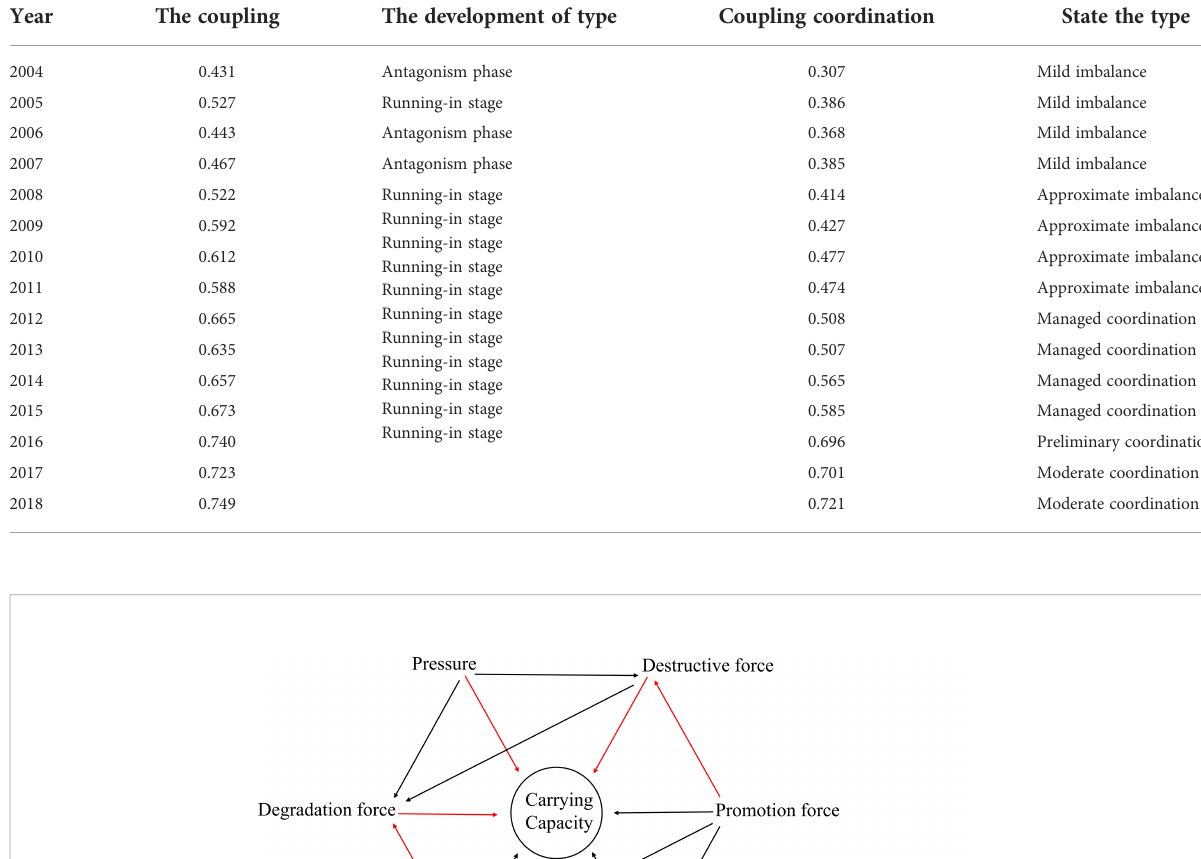
TABLE 4 Classi fi cation of the coupling degree and coordination degree of the marine resources and environmental carrying capacity systems in Zhejiang Province from 2004 to 2018.